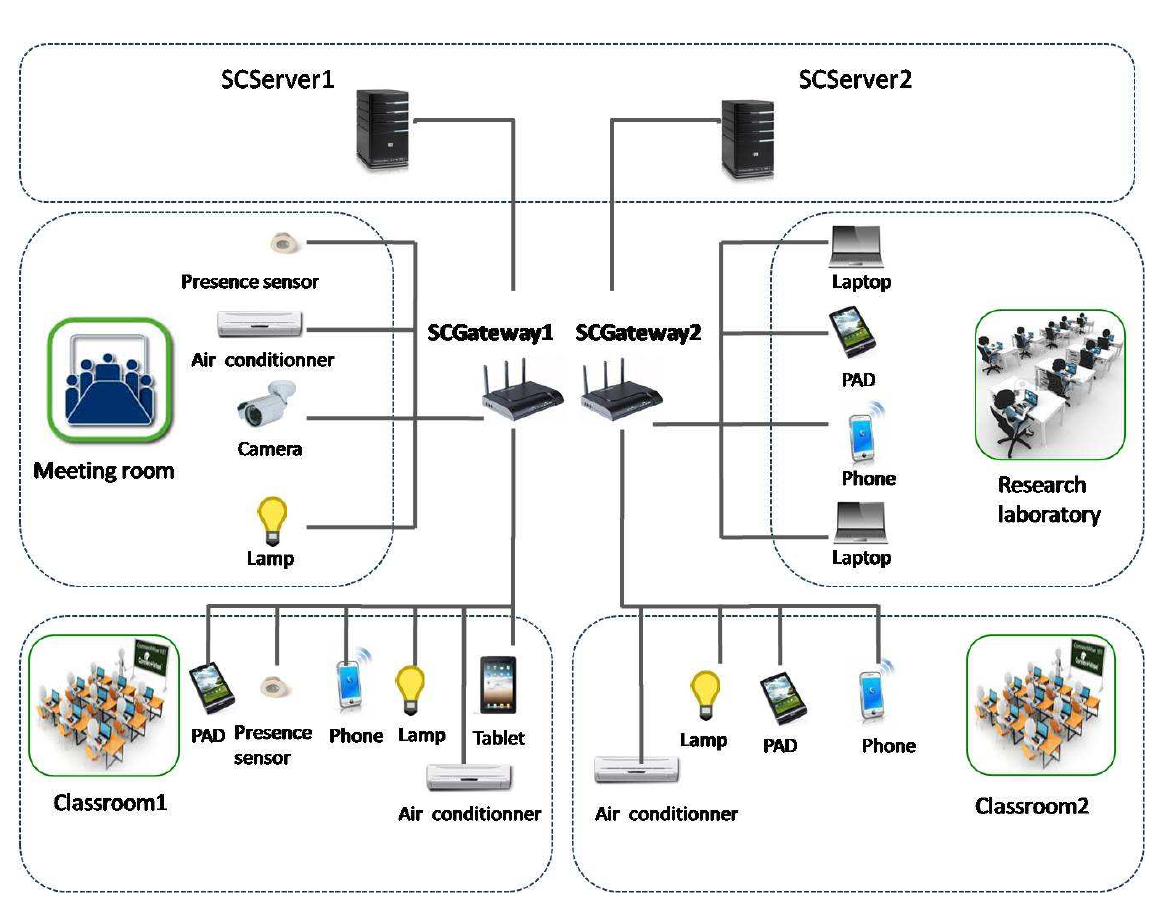
Figure 2. Case study: Smart